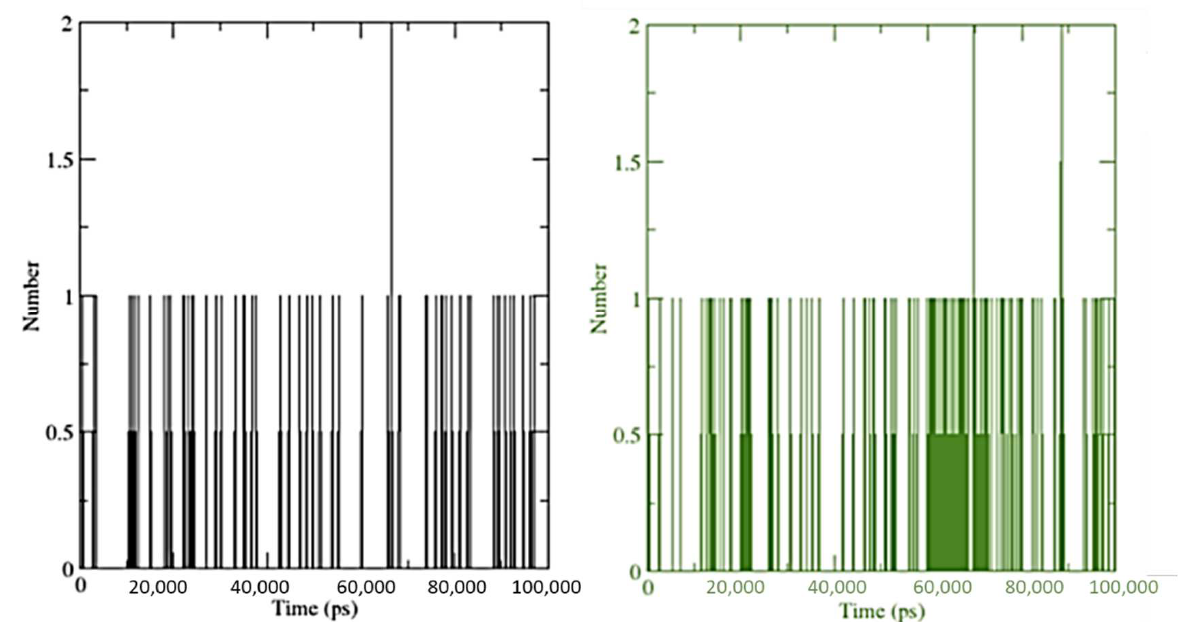
Figure 15. Number of average hydrogen bonding interactions between ( Left ) SRXD complex and ( Right ) CTcD complex during 100 ns simulation time.